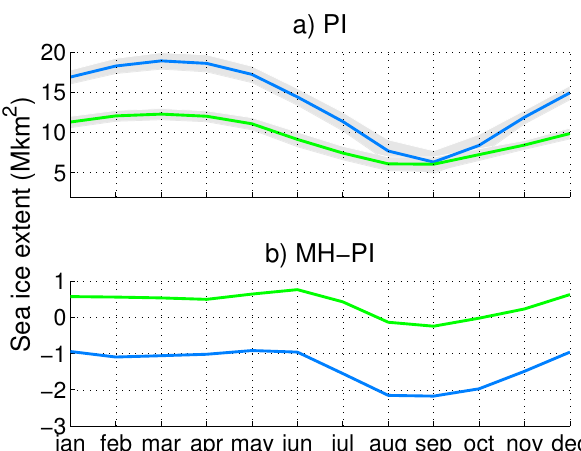
Fig. 9. Seasonal cycle of sea-ice extent in the pre-industrial climate for the HadGEM2-ES (blue line) and the MIROC-ESM (green line). The lower panel shows the same for the mid-Holocene climate. The shaded area is the 2 times standard deviation for a 100yr